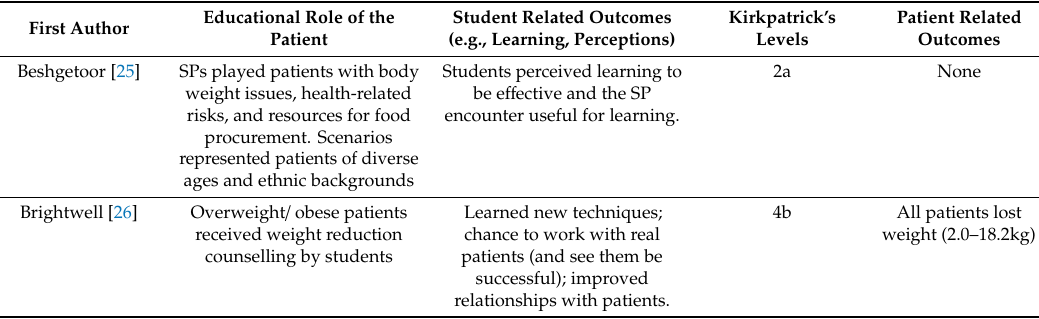
Table 2. Study outcomes and Kirkpatrick’s Hierarchy of included